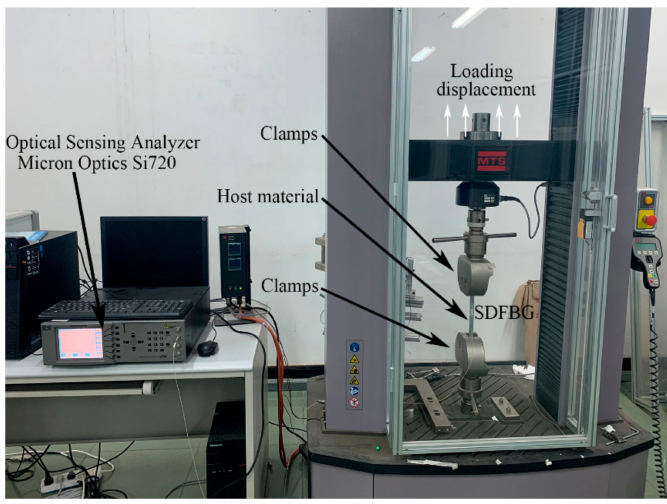
Figure 9. Experiment setup for strain